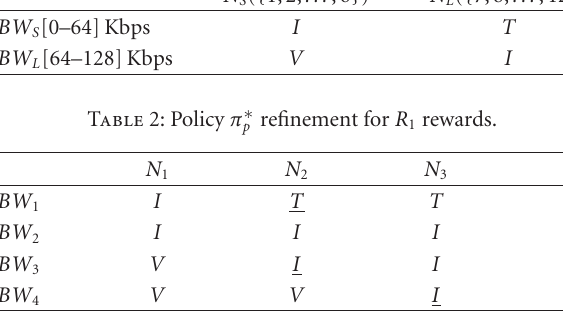
Table 1: Policy π ∗ stated for two-level granularity n and bw ). p